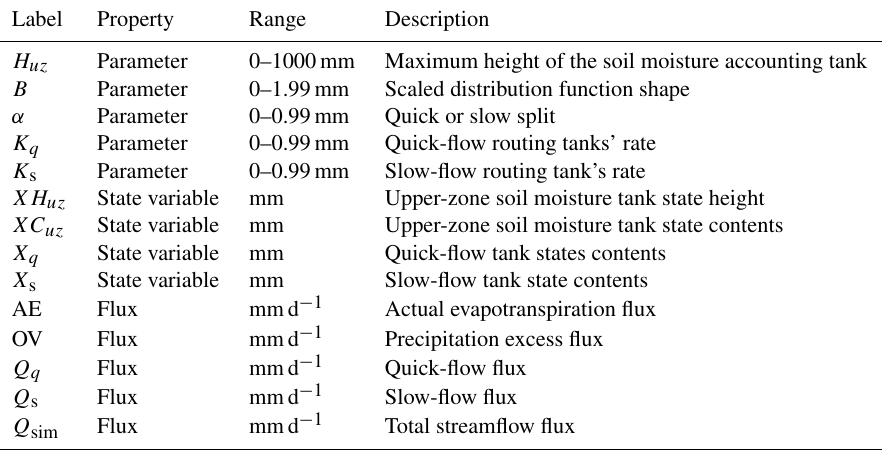
Table 1. Definition of parameters, state variables and fluxes used in the HYMOD model (Wagener et al., 2001). Label